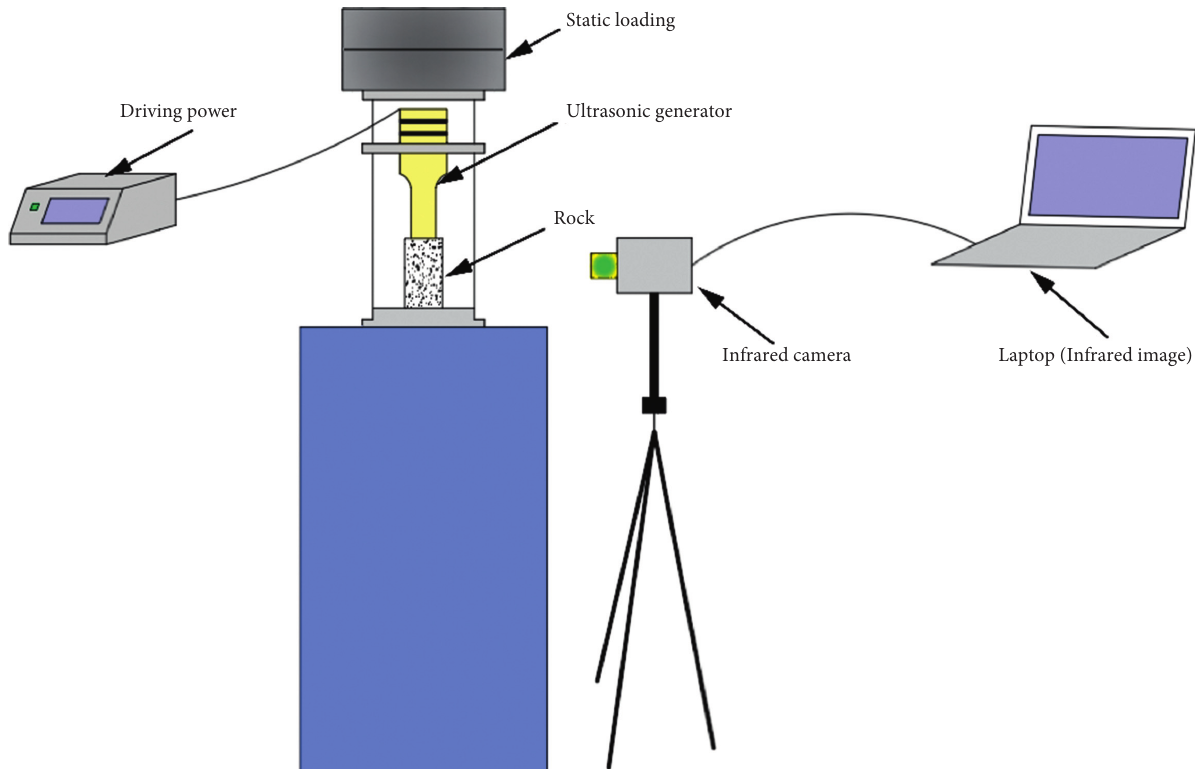
Figure 4: Experimental system diagram.